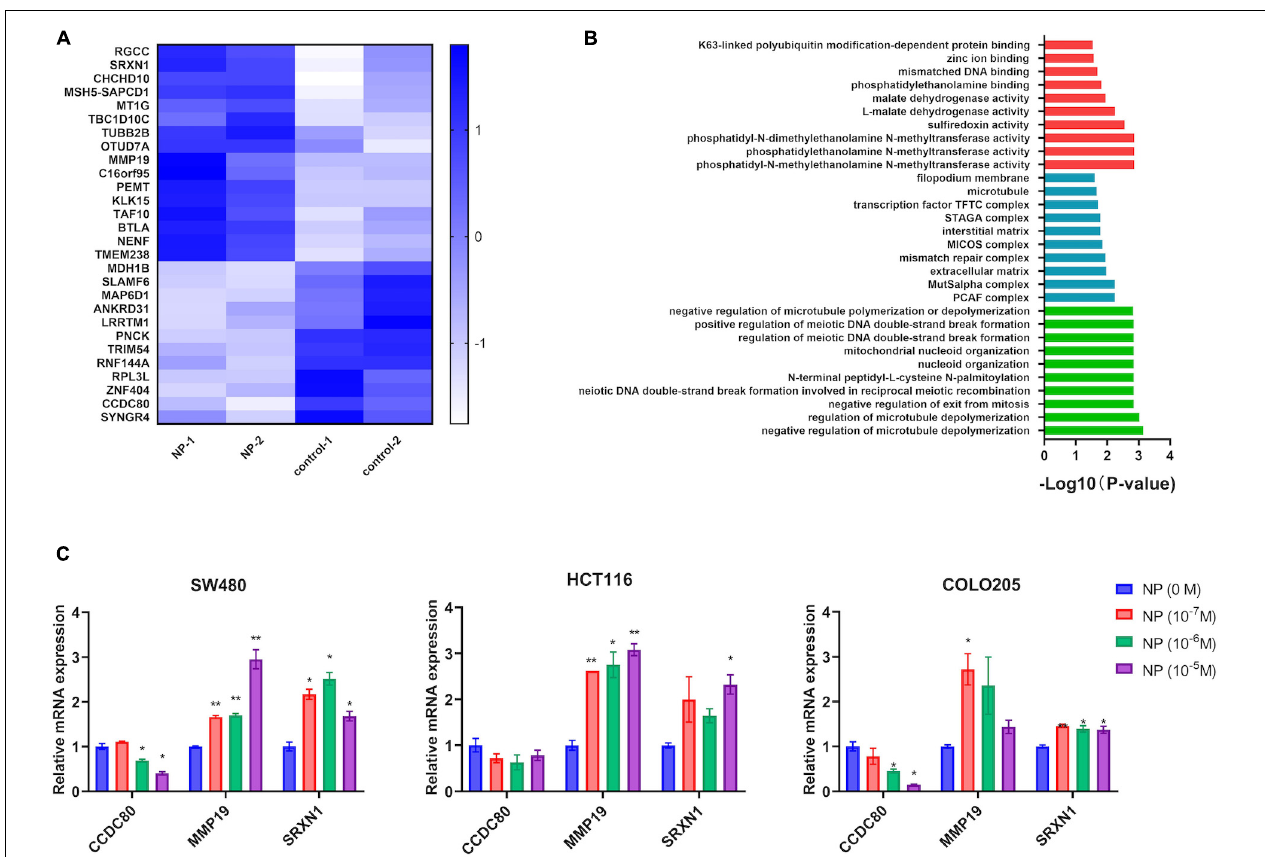
FIGURE 3 | Nonylphenol (NP) influences the gene expression profile in colorectal cancer (CRC) cells. (A) Heatmap showing the differentially expressed genes in COLO205. (B) Gene ontology (GO) enrichment analysis of differentially expressed genes. Red: top 10 of molecular function terms; blue: top 10 of cellular component terms; green: top 10 of biological process terms. (C) RNA expression of CCDC8, MMP19, and SRXN1 in NP treated COLO205, SW480, and HCT116 cells as tested using quantitative PCR (qPCR). * p < 0.05, ** p < 0.01, compared to NP (0 M).